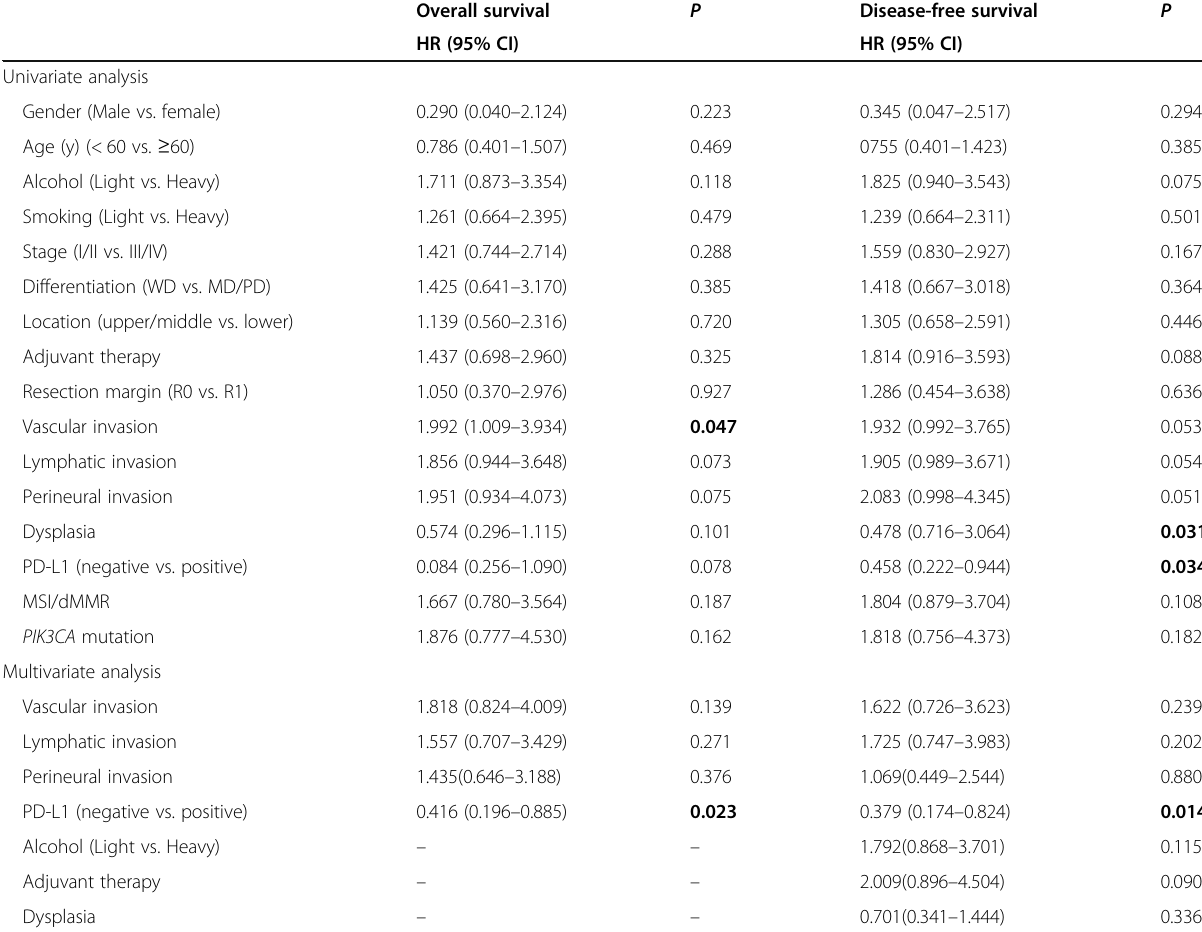
Table 3 Univariate and multivaritate analyses of overall survival and disease-free survival of patients with ESCC Overall survival